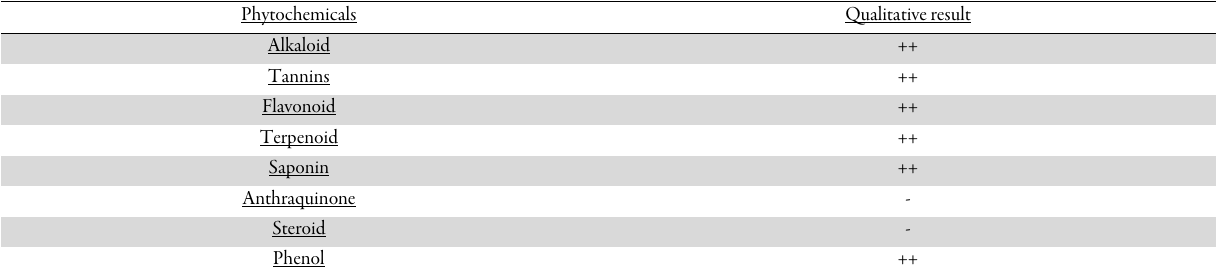
Table 1. Qualitative analysis of aqueous leaf extract of Securinega virosa